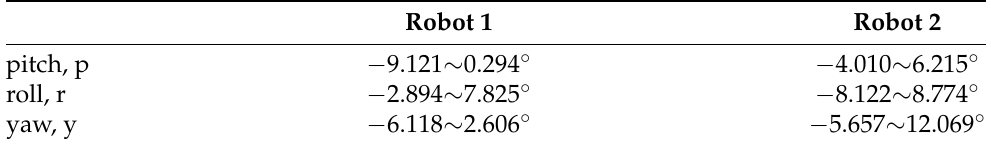
Figure 9. Feet trajectory for two connected robots walking together. Displacement of the feet trajectory of Robot 1 along with the ( a ) x -axis, ( b ) y -axis, and ( c ) z -axis. Displacement of the feet trajectory of Robot 2 along the ( d ) x -axis, ( e ) y -axis, and ( f ) z -axis. Table 1. Angle variation of the robot’s